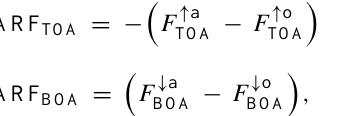
Fig. 9. Single scattering albedo (SSA) as a function of wavelength at different AOT thresholds in